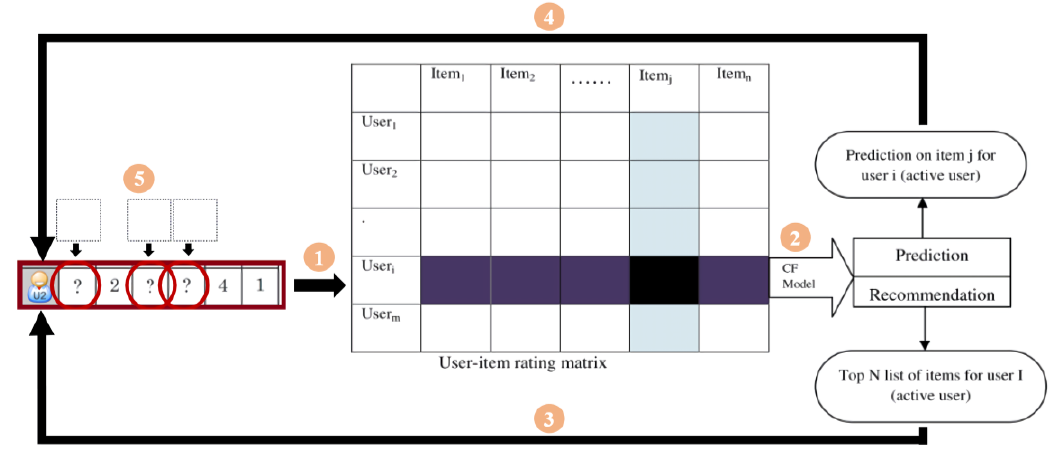
Figure 3. Collaborative filtering